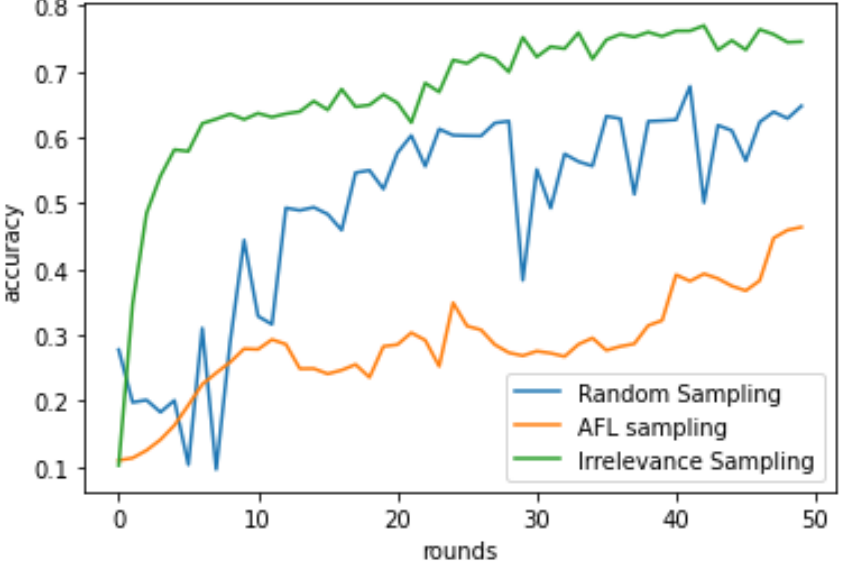
Figure 10. Performance comparison on a highly skewed, moderately free rider repleted and class imbalance environment with 3 classes present only on clients with less than 3